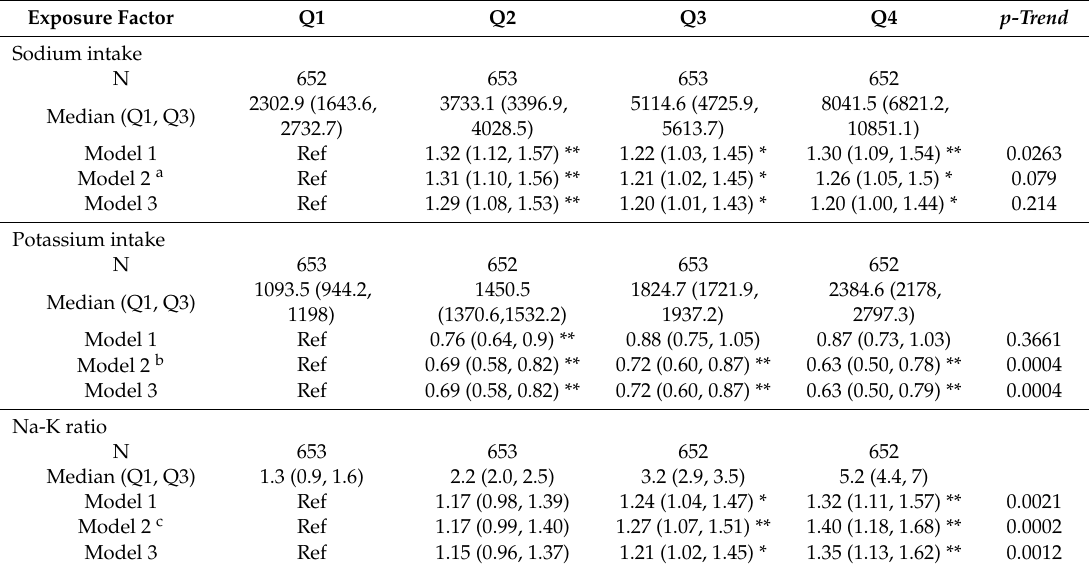
Table 3. Associations between dietary sodium, potassium, and sodium-potassium ratio and risk of hypertension in North